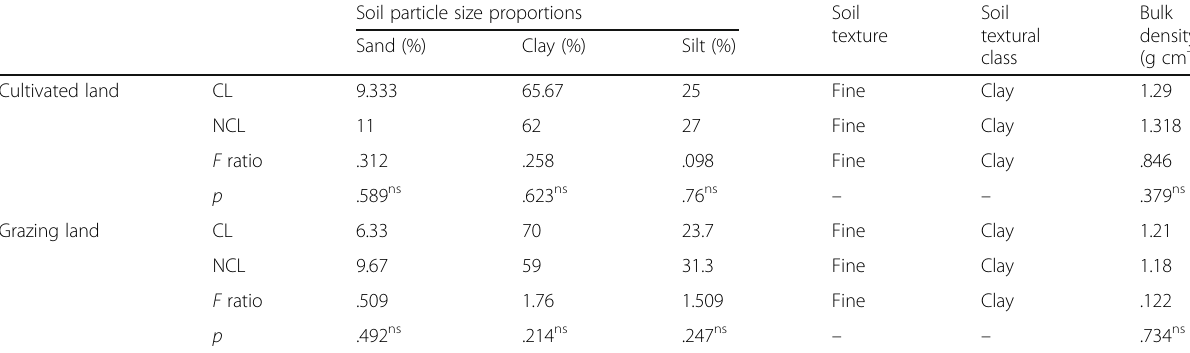
Table 4 The effect of SWC practices on soil physical properties in different land uses (cultivated and grazing land) Soil particle size proportions Soil texture